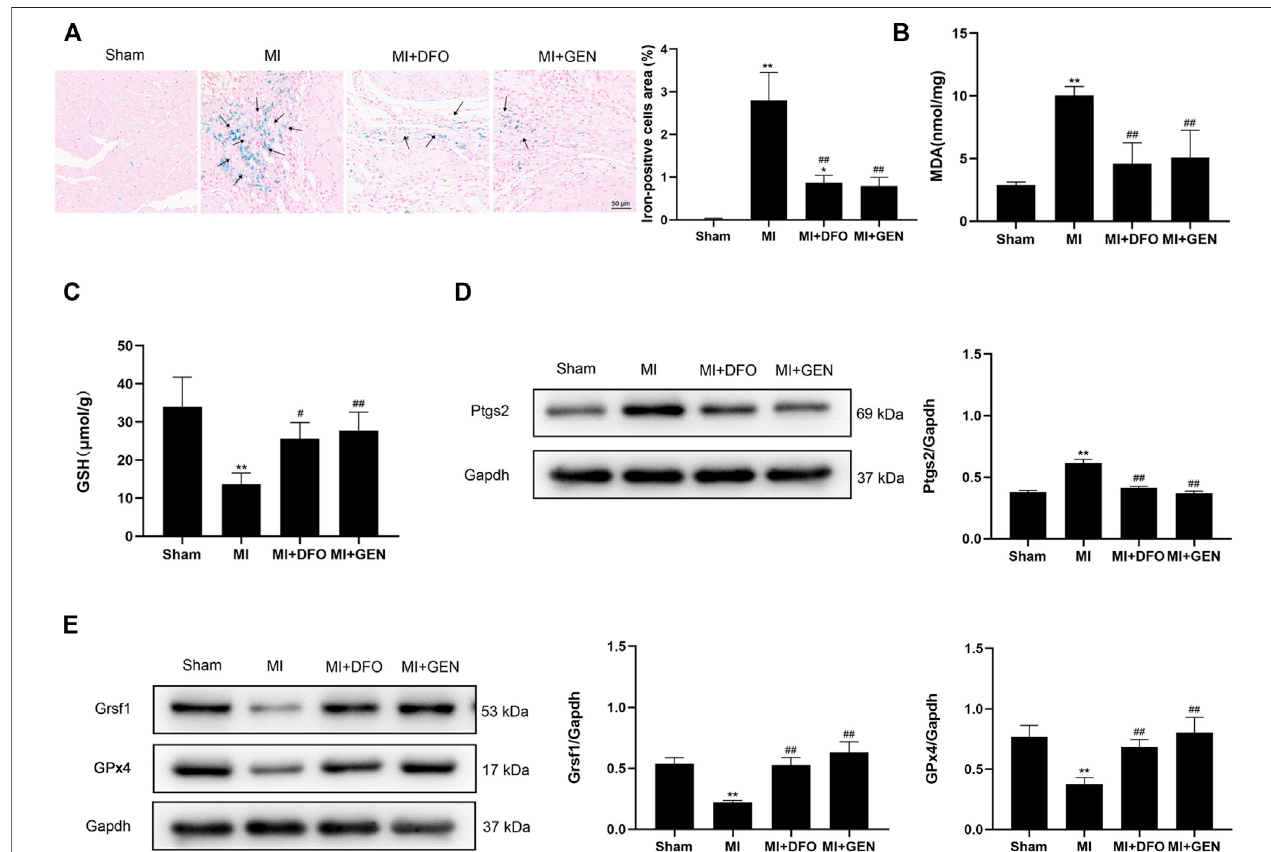
FIGURE 4 | GEN inhibits MI-mediated ferroptosis. (A) Prussian blue staining of iron deposition in rat heart tissues. (B,C) MDA and GSH contents in rats of Sham, MI, MI + DFO, and MI + GEN group. (D) Expression levels of the ferroptosis marker Ptgs2 in rat heart tissues. (E) Grsf1 and GPx4 expression levels in the heart tissues. Data were expressed as mean ± SD ( n = 8). * p < 0.05, ** p < 0.01 vs. Sham group; # p < 0.05, ## p < 0.01 vs. MI group. Scale bar = 50